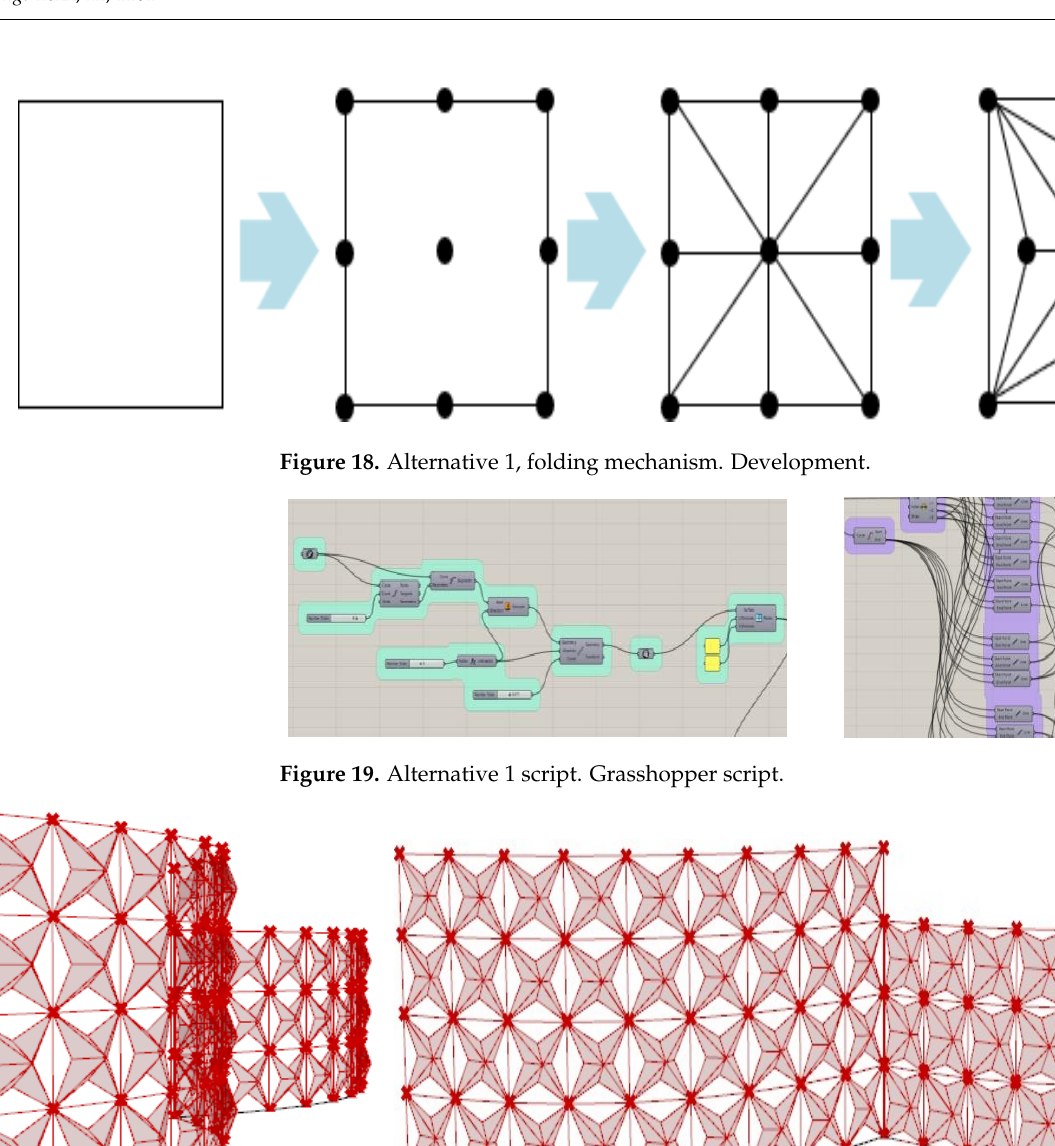
Figure 21. Visual connection indoor–outdoor. The second parameter is defined by minimizing the solar radiation on the façade of the new building (extension of the library). This study targeted the peak hours of the